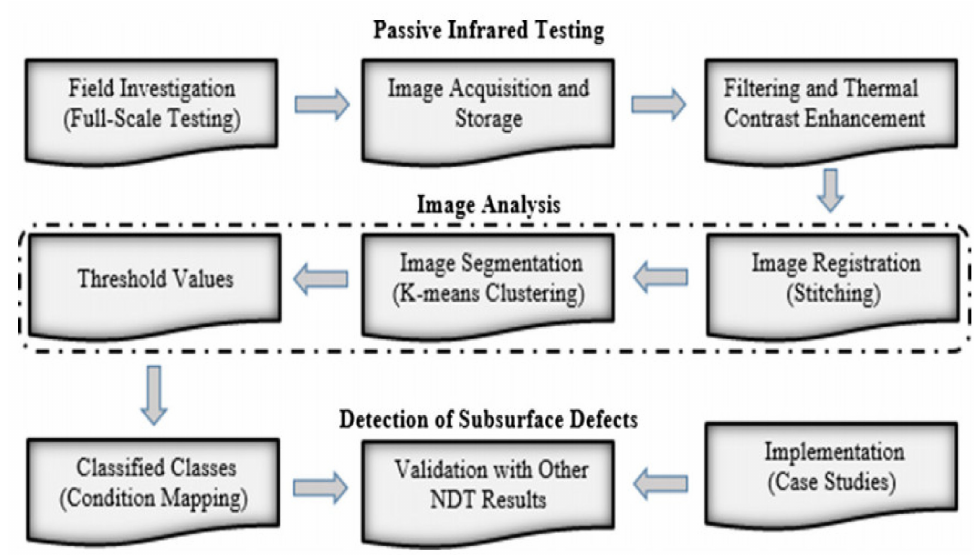
Figure 11. Proposed IRT methodology